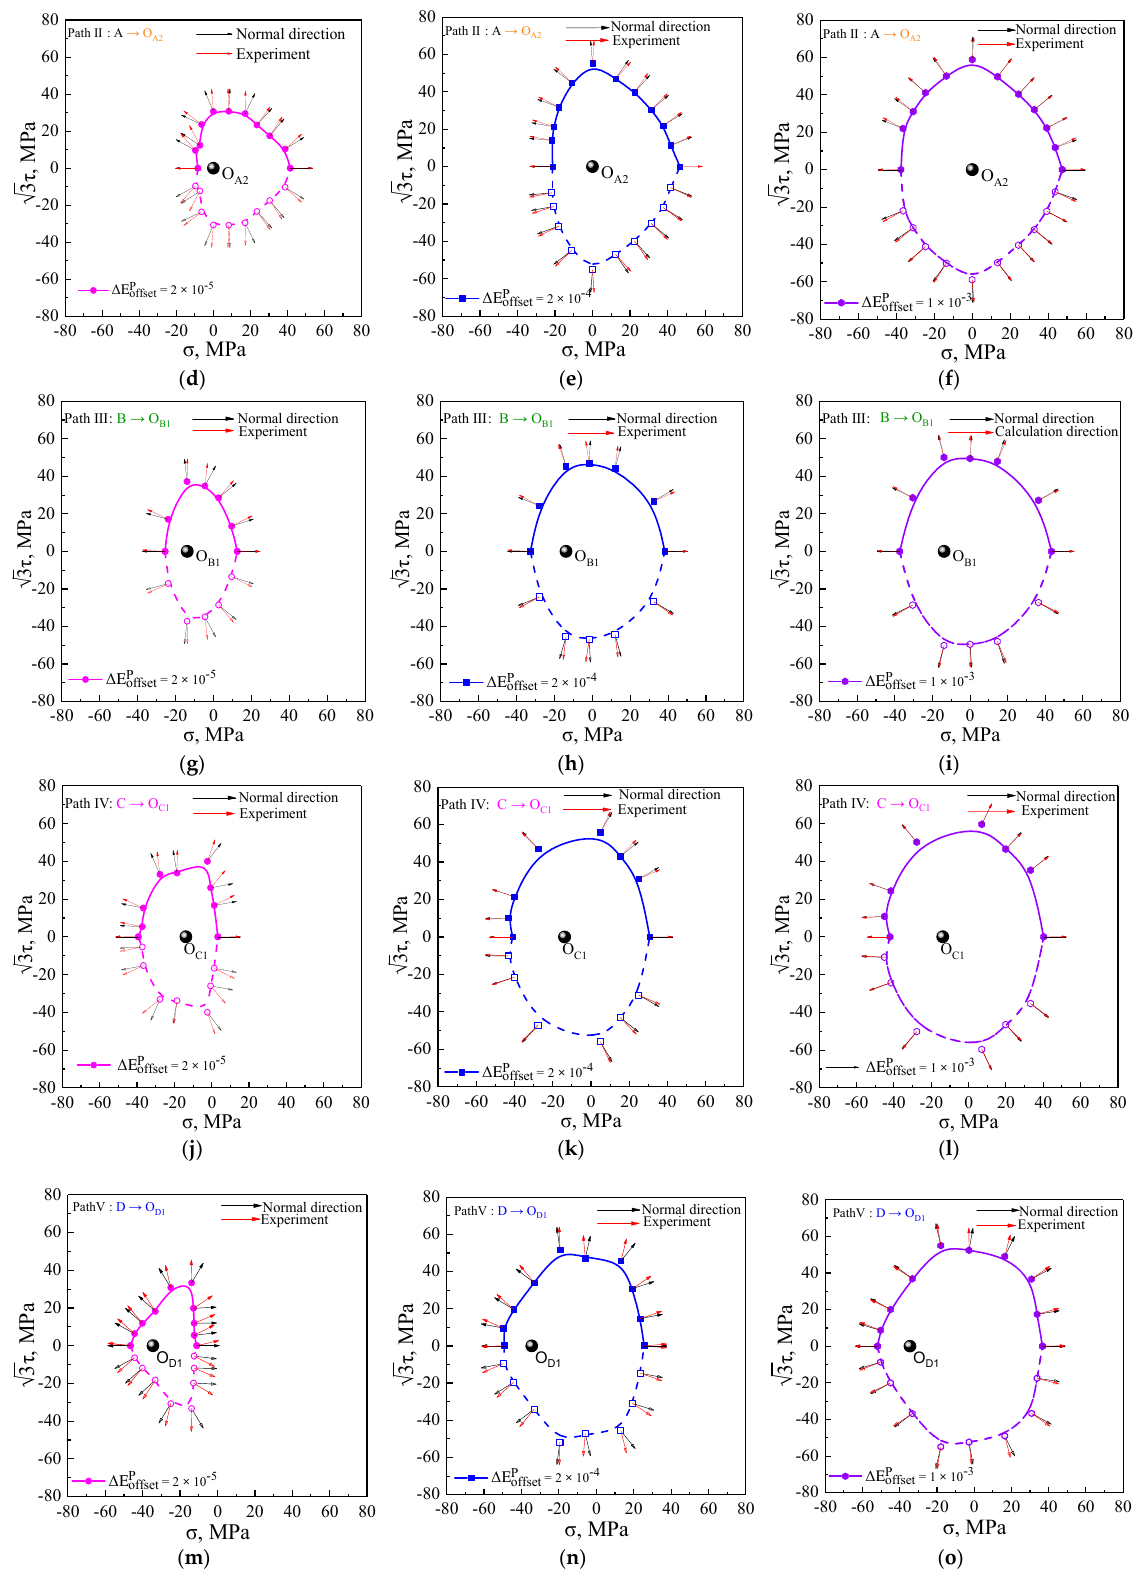
Figure 12. Comparison of plastic flow directions between theoretical calculations and experimental test at offset strain of 20 μ , 200 μ , and 1000 μ under five unloading cases: ( a – c ) at unloading points O A1 ; ( d – f ) at unloading points O A2 ; ( g – i ) at unloading points O B1 ; ( j – l ) at unloading points O C1 ; ( m – o ) at unloading points O D1 .